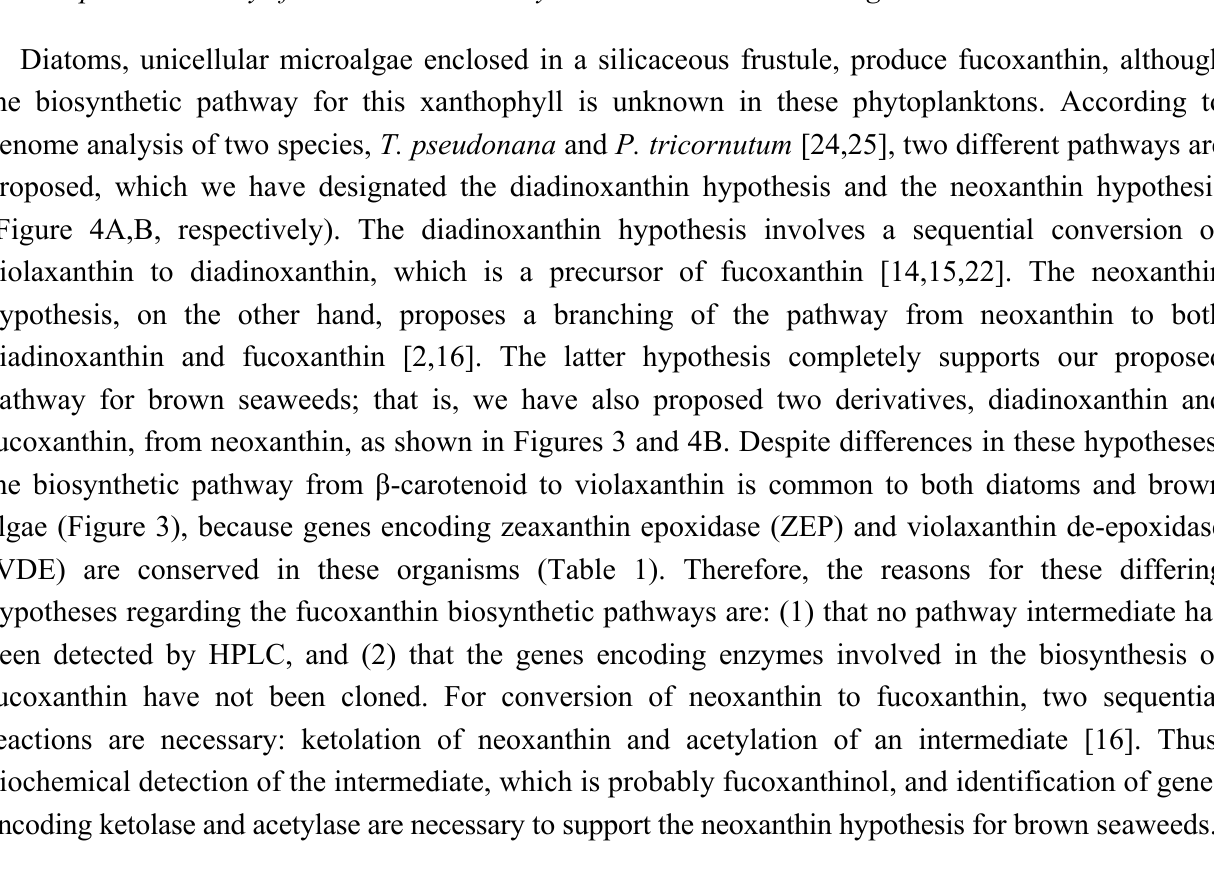
Table 1. Comparison of carotenogenic genes involved in xanthophyll